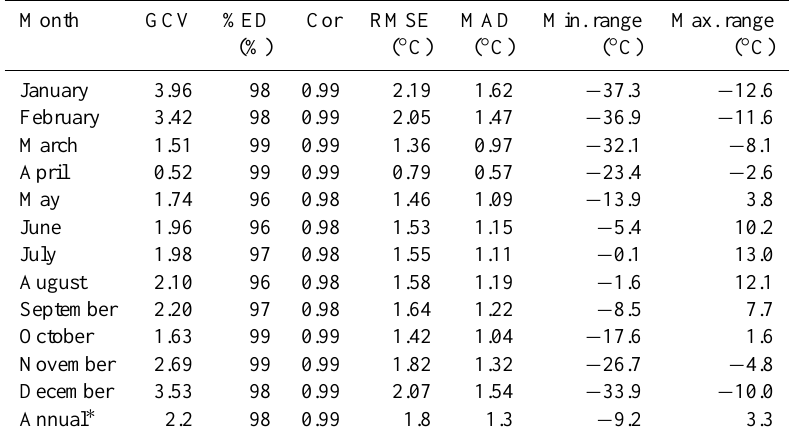
Table 2. Skills and calibration ranges of the monthly mean temperature GAMs for the Northern European area, and of the annual mean temperature ( ∗ ) GAM for the Western Eurasian area. Same abbreviations as in Table 1. Month GCV %ED Cor RMSE MAD Min. range Max. range (%) ( ◦ C) ( ◦ C) ( ◦ C) ( ◦